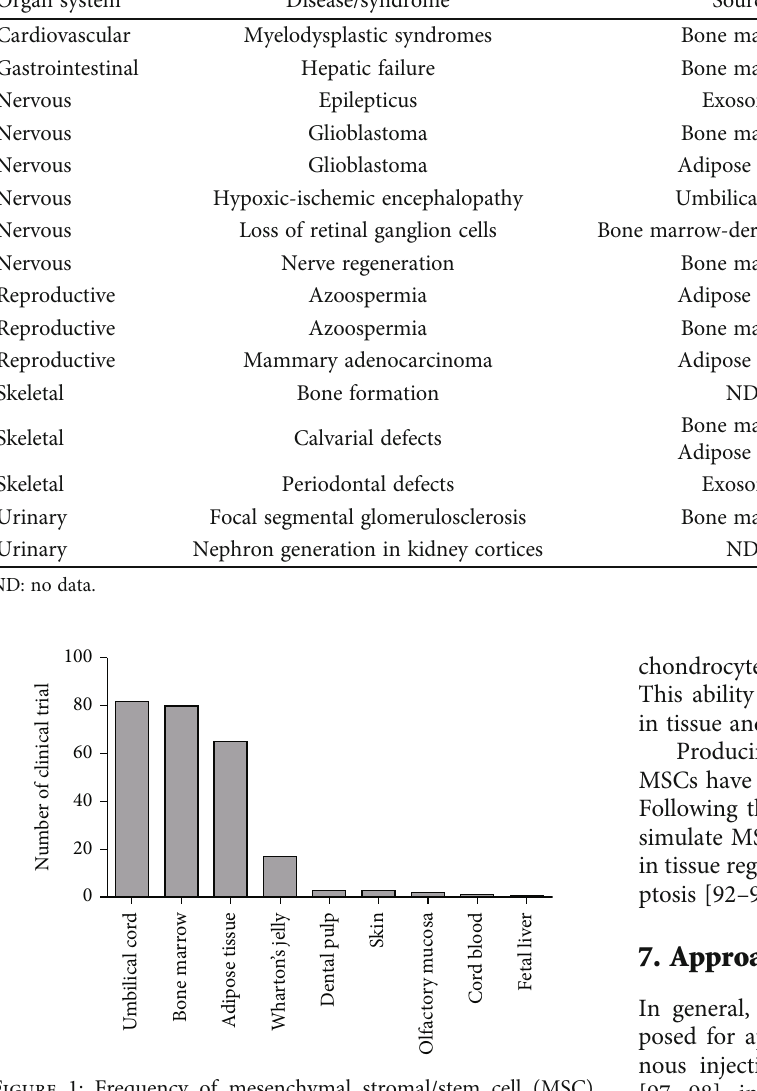
Figure 1: Frequency of mesenchymal stromal/stem cell (MSC) source contributions in clinical trials on MSC therapy during 2016-2020 (U. S. National Library of